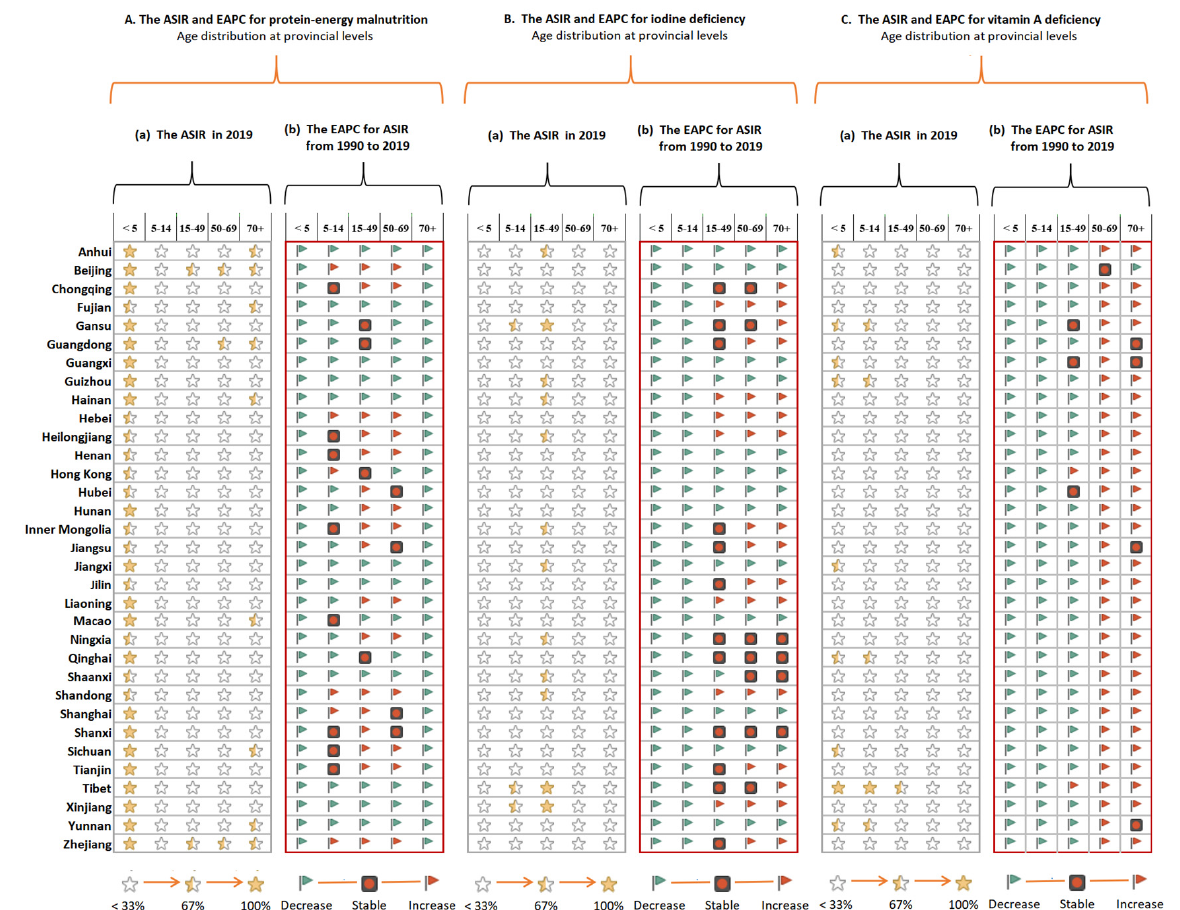
Figure 6. The age-standardized incidence rate for main subcategories in 2019 and their estimated annual percentage changes (EAPC) from 1990 to 2019 by ages at provincial levels of China.